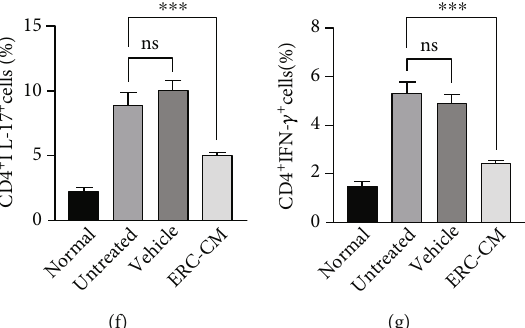
Figure 4: ERC-CM decreased the percentages of Th1 cells, Th17 cells, and M1 macrophages but increased the percentage of Tregs in the spleen of colitis mice. Splenocytes were collected on day 10 after DSS induction. To accurately identify the subpopulation of Th1 and Th17 cells, splenocytes were fi rstly incubated with a cell stimulation cocktail for 6 hours before being stained with fl uorescent antibodies. Percentages of F4/80 + CD86 + M1 macrophages (a), representative dot plots of CD4 + CD25 + Foxp3 + Tregs (b), CD4 + IL-17 + Th17 cells (c), and CD4 + IFN- γ + Th1 cells (d) were shown. Data shown were representative, and the p value was determined by one-way ANOVA. ∗ p < 0 : 05 , ∗∗ p < 0 : 01 , ∗∗∗ p < 0 : 001 , and ∗∗∗∗ p < 0 : 0001